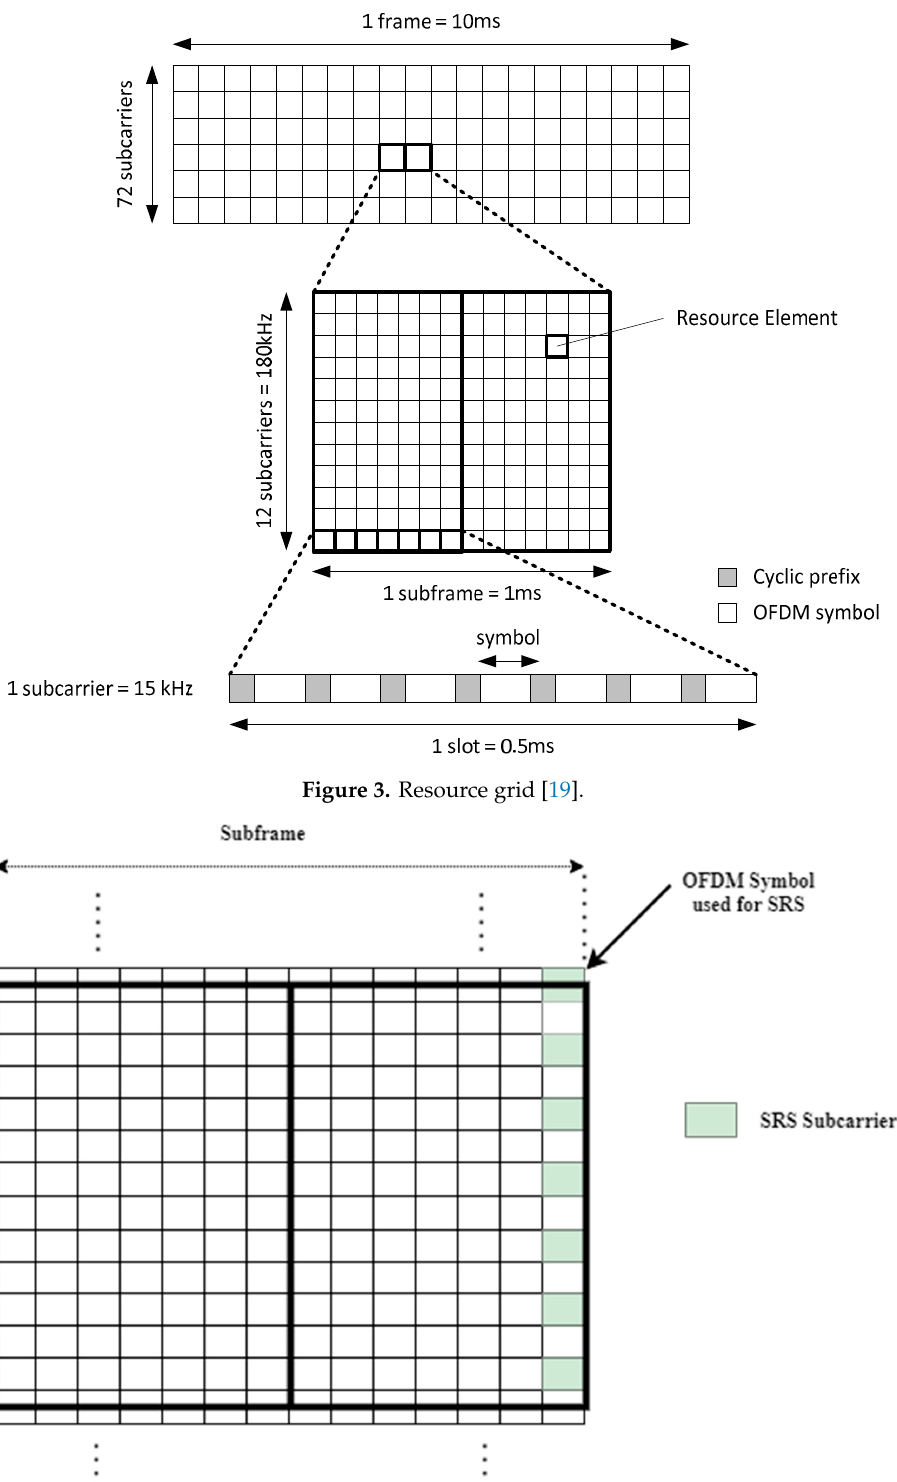
Figure 4. Sounding Reference Signals (SRS) configuration on a subframe [16].